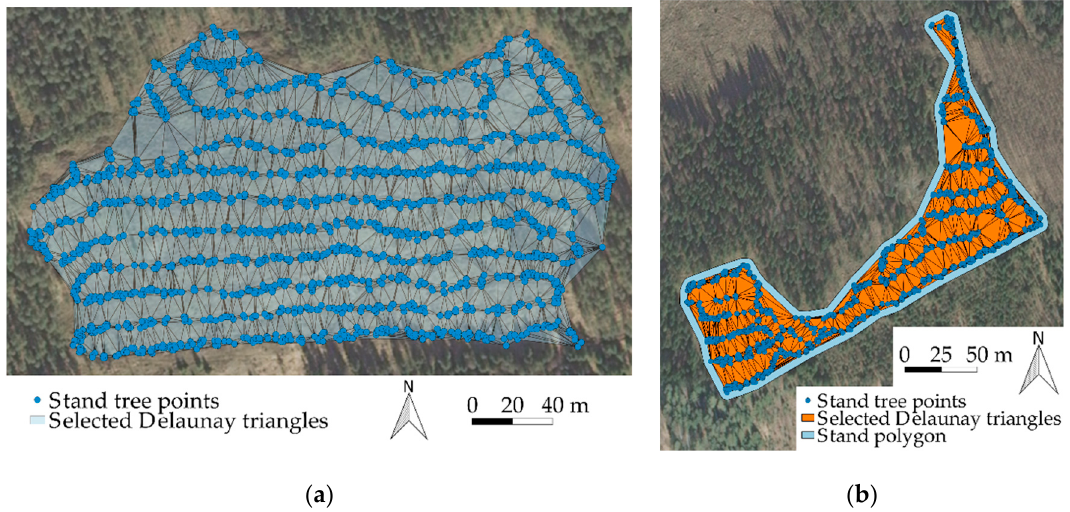
Figure 5. Examples of Algorithm A2 at clear cut objects where harvester was known to have more accurate GNSS. The ETRS-TM35FIN (EPSG:3067) coordinate system is used in the figure. Aerial images © National Land Survey of Finland. ( a ) The selected triangles from Delaunay triangulation form the preliminary stand area. ( b ) The triangles are dissolved and buffered to obtain the stand polygon.